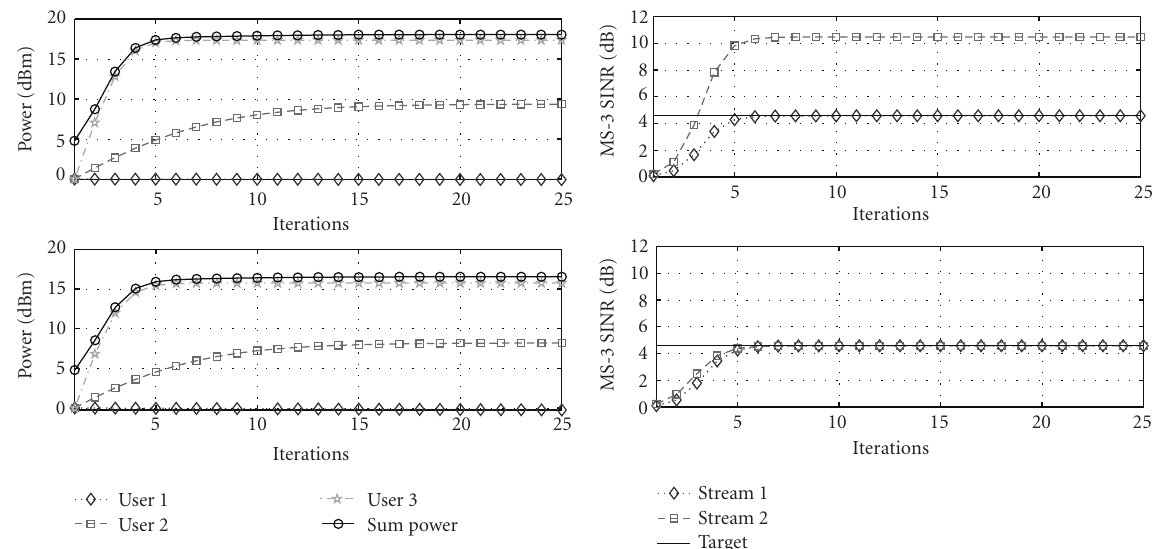
(b) SINR evolution for the two streams of MS-3 without (upper) and with(lower)precodinginCase1.Withprecoding,thetransmitweights keep the stream SINR values “together,” while without precoding, one of the SINR values “overshoots”